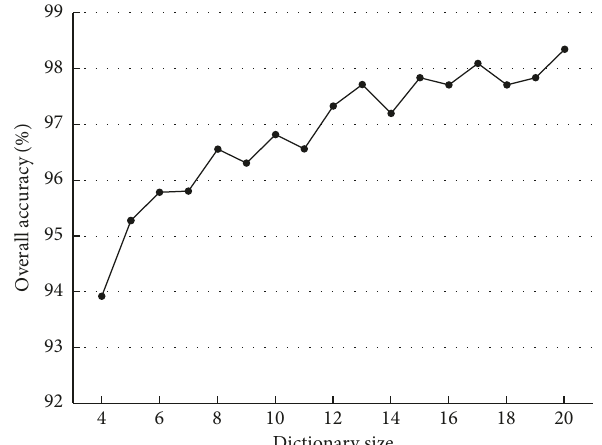
Figure 6: The overall accuracy on the updated dictionary with different